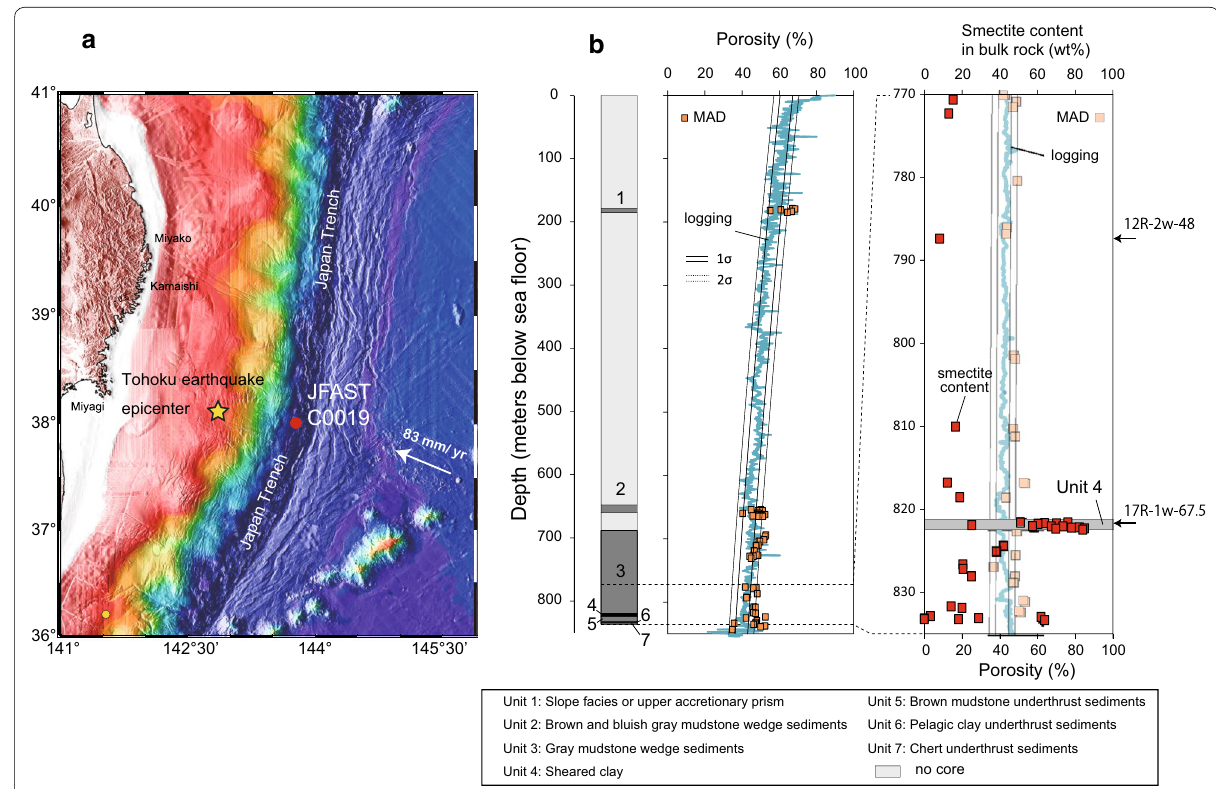
Fig. 1 Location, lithological units, porosity and mineralogical profiles of the JFAST drill site. a Location of the JFAST drill site (Site C0019; modified from Kimura et al. 2012). b Lithological units at the JFAST drill site, porosity profile deduced from logging data and core sample analysis (MAD), and variations in the bulk-rock smectite content. The solid and dotted lines along the porosity profile represent 1 σ and 2 σ , respectively. Note that the fault zone (Unit 4) is strongly enriched in